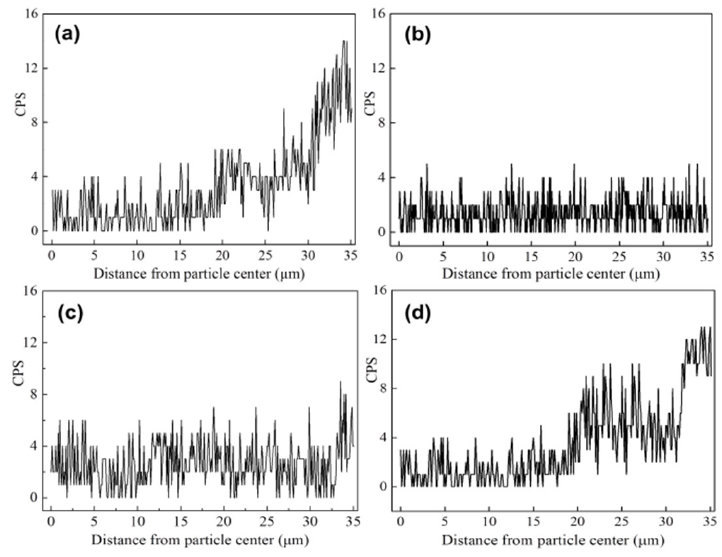
Figure 4. Iron distribution in a particle: ( a ) E-cat, ( b ) CAT-MM1, ( c ) CAT-MM2, and ( d ) CAT-CD. CPS: Counts Per Second.